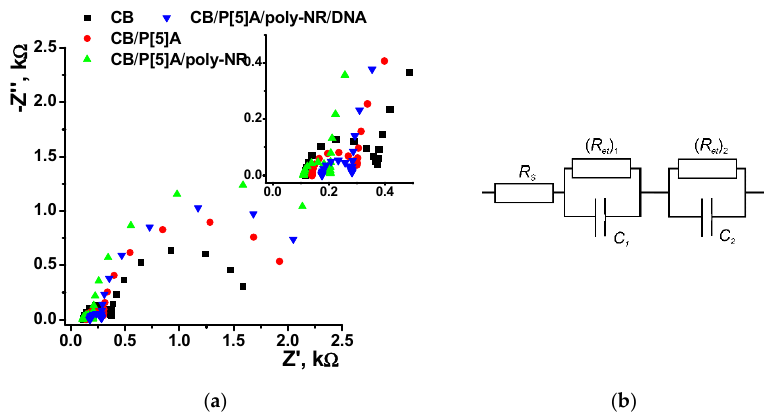
Figure 7. ( a ) The Nyquist diagram of impedance spectra recorded with glassy carbon electrode covered with CB, CB/P[5]A, CB/P[5]A/poly-NR and CB/P[5]A/poly-NR/DNA layers (Inset: small semicircle area). Measurements in the presence of 0.01 M K 3 [Fe(CN) 6 ] and 0.01 M K 4 [Fe(CN) 6 ] at 220 mV vs. Ag/AgCl. Frequency range 0.04 Hz–100 kHz, amplitude 5 mV. ( b ) Equivalent circuit: R S —solution resistance, R et —charge transfer resistance, C —capacitance, 1 and 2 indices correspond to the inner and outer interface of the layer.